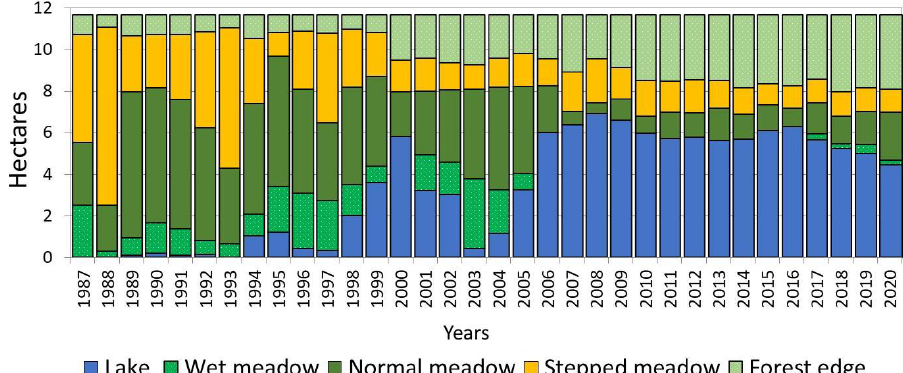
Figure 2. Dynamics of the model alas spatial structure.